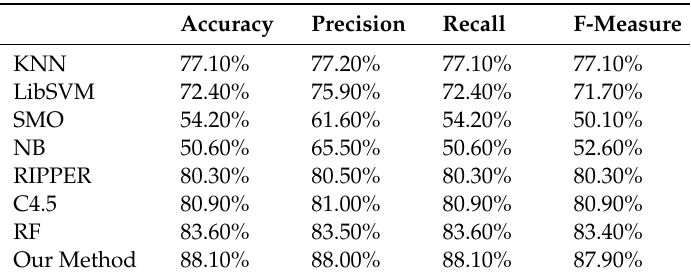
Table 4. Tulum2010 performance.